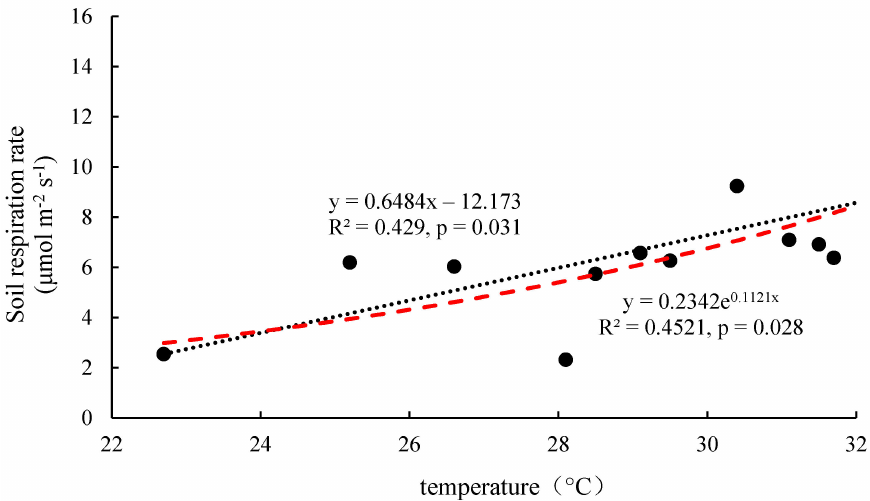
Figure 5. The relationship between soil temperature and soil respiration